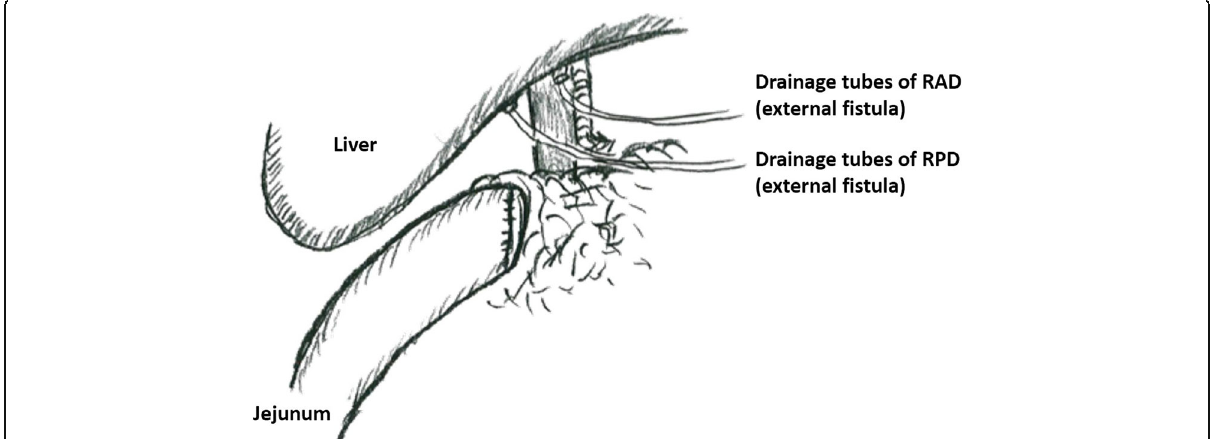
Fig. 1 In redo surgery, biliary drainage tubes that were inserted from the stumps of the RAD and PRD were exteriorized through the abdominal free space and abdominal wall. The jejunum was simply placed and fixed near the RAD and RPD for future anastomosis by MCA. RAD right anterior duct, RPD right posterior duct